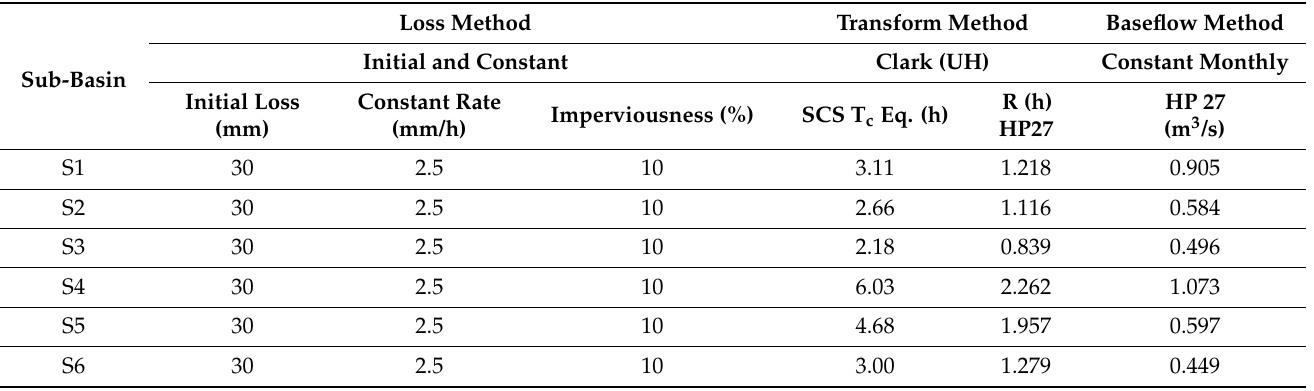
Table 2. Input Parameter of